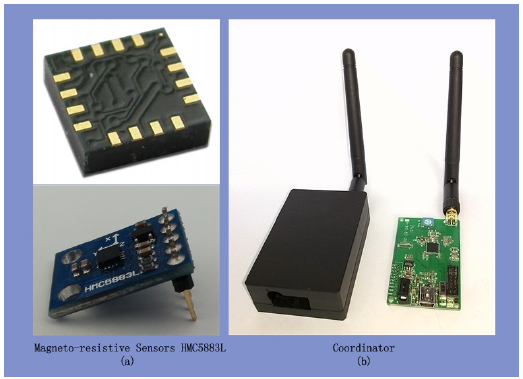
Fig. 2. Magnetoresistive Sensors HMC5883L and Zigbee